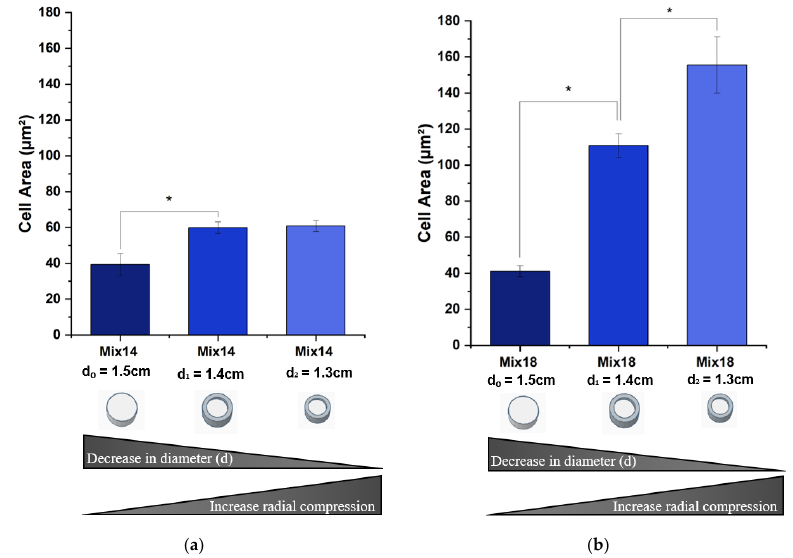
Figure 7. Comparison of cell body area on Mix-14 and Mix-18 aerogels. In the relaxed form, the PC12 cells plated on ( a ) Mix-14 had similar areas to those measured on ( b ) Mix-18. As the substrate received an increasing degree of radial compression, the cell area was affected more significantly for cells plated on Mix-18. Average was calculated from three independent trials (N = 3) with over 100 measurements (n > 100) each. Error bars represent the standard error of the mean. Asterisks (*) denote values that are statistically significant (p < 0.05).